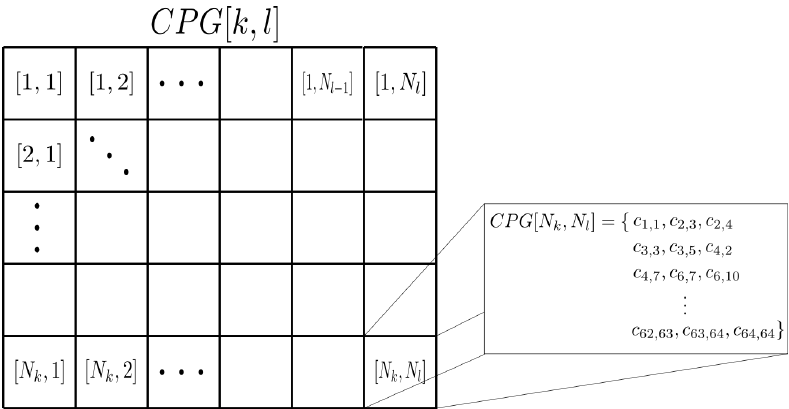
Figure 4. Example of Coarray Projection Grid ( CPG ) where each [ k , l ] position contains a set of coarray elements c ij that meet the condition